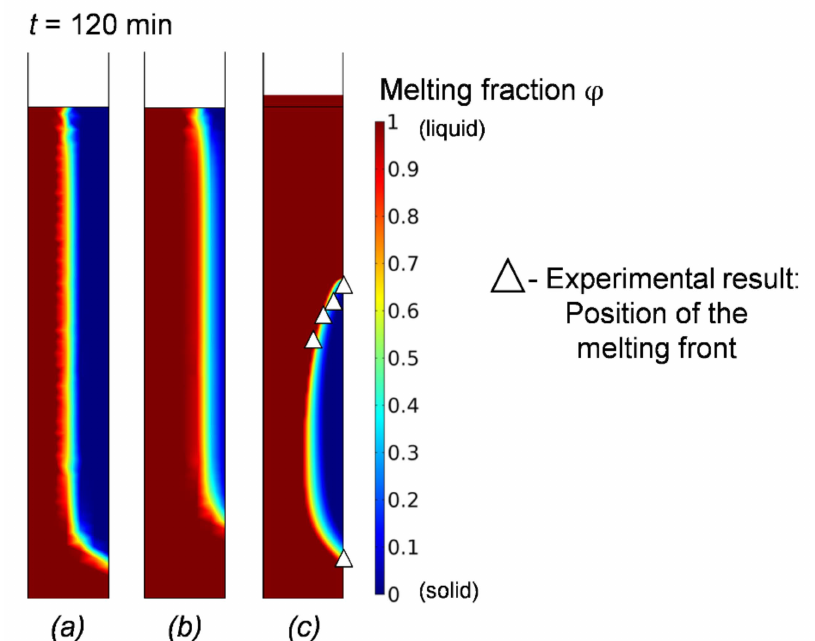
Figure 7. Melting fraction after 120 min: ( a ) Default model , ( b ) Default model with factor 2, ( c ) Enhanced model with convection flow and volume change and the experimental